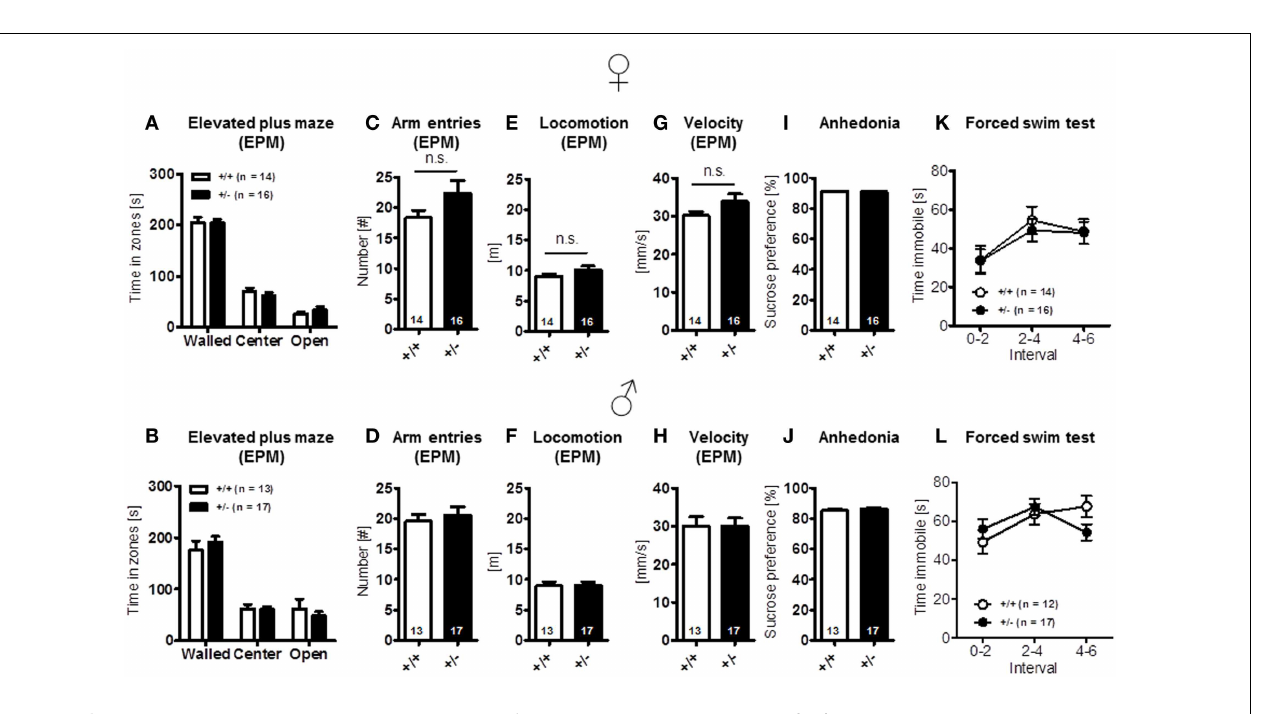
plus-maze readouts; (I–L) sucrose preference and forced swim test as readouts of depression. Mean ± SEM presented; respective sample sizes are indicated in the